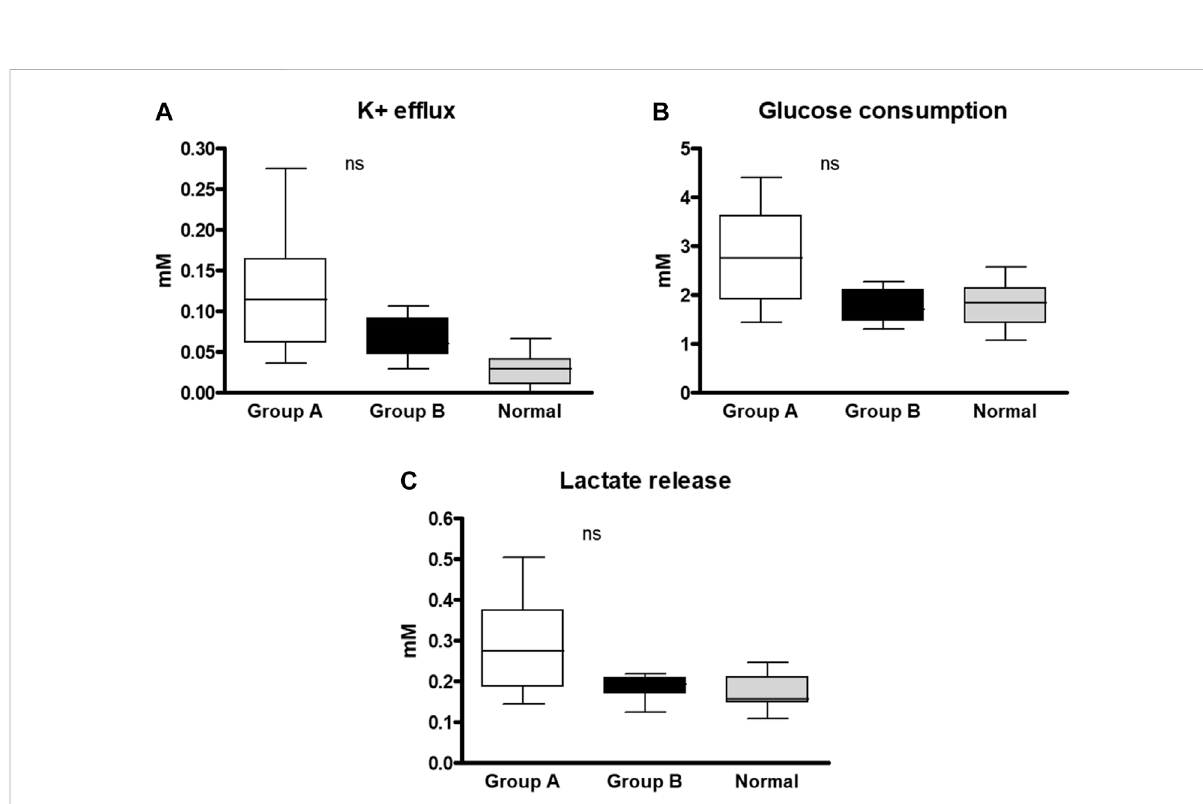
FIGURE 2 RBC membranepermeability and metabolicproperties of SCDsubjects and healthy control. Samples ofeach group wereincubated for 4 h ina plasma-likemedium andexaminedfor: (A) K+ef fl ux, (B) Glucoseconsumption,and (C) Lactaterelease.The4vs.0 hdifferencewasnormalizedwith total hemoglobin concentration. The correspondent examination of RBCs obtained from control subjects ( n = 14; 8M/6F; 34.1 ± 16.1 years) was made. The data is presented in average ±SD; the signi fi cance is < 0.05. Group (A) patients with asplenia/hyposplenism, Group (B) patients with